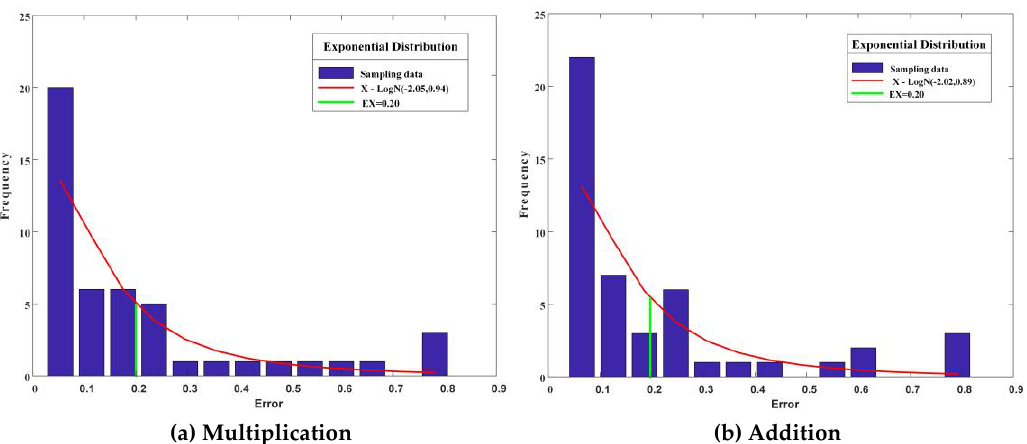
Figure 9. Estimation error distribution of two adjustment methods for Type-2.